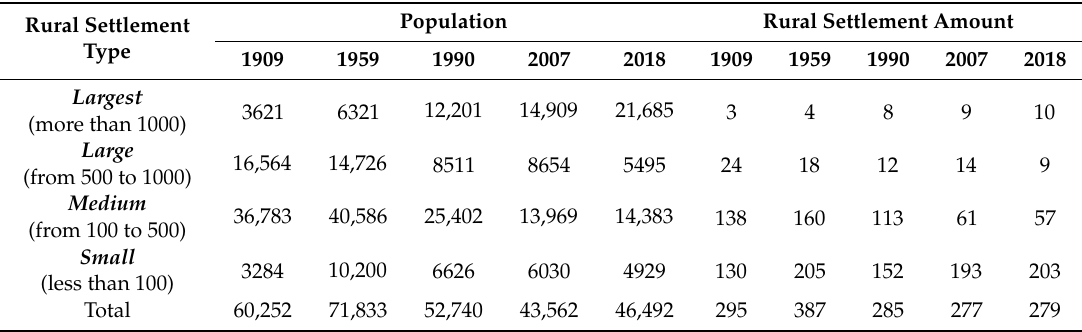
Table 3. Population and rural settlement amount (in absolute units) within the current boundaries of the Mogilev district from 1909 to 2018.